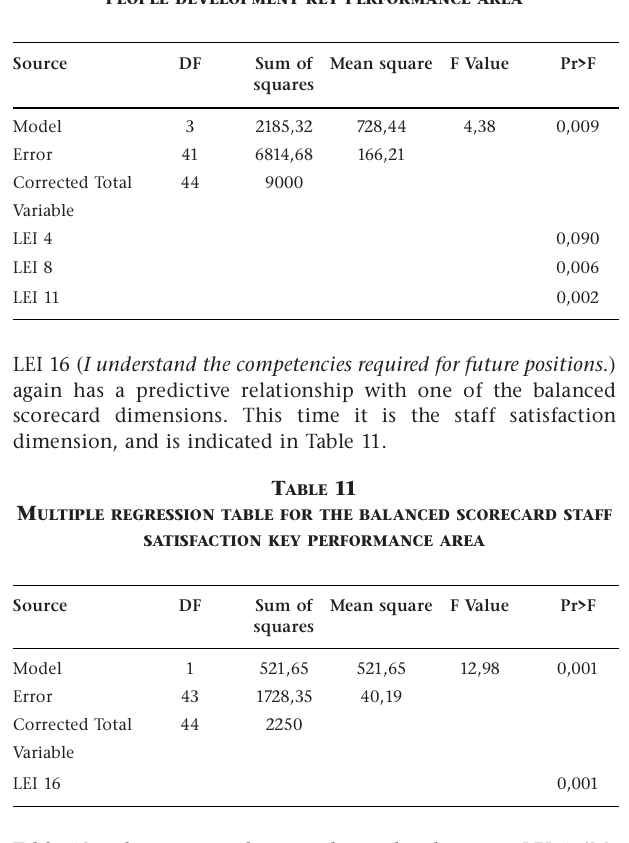
Table 12 indicates a predictive relationship between LEI 1 ( My leader inspires people to achieve the business vision .), and LEI 6 (